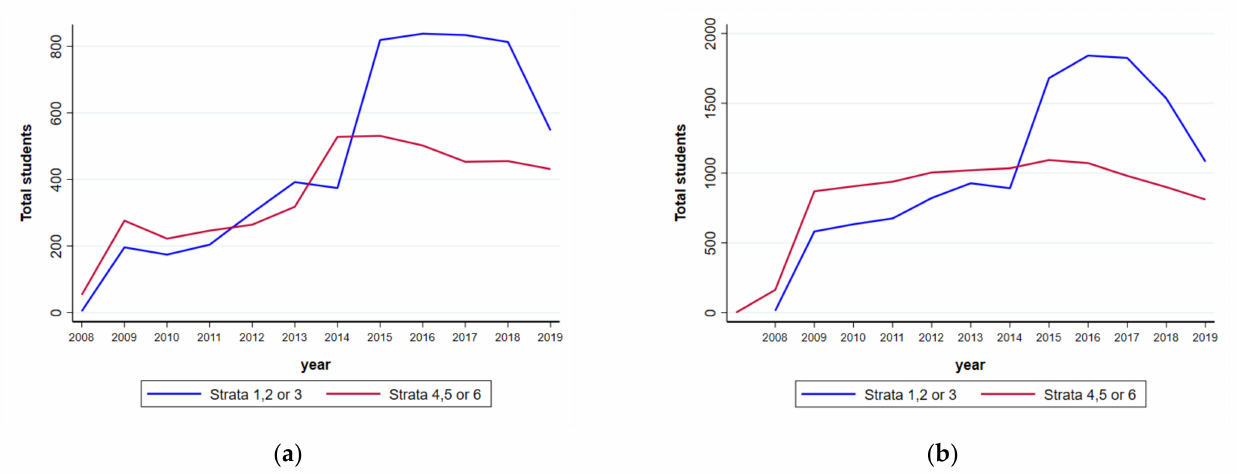
Figure 1. Distribution of total students according to stratum and year: ( a ) Calculus I; ( b ) Communication Skills I. Source: Authors’